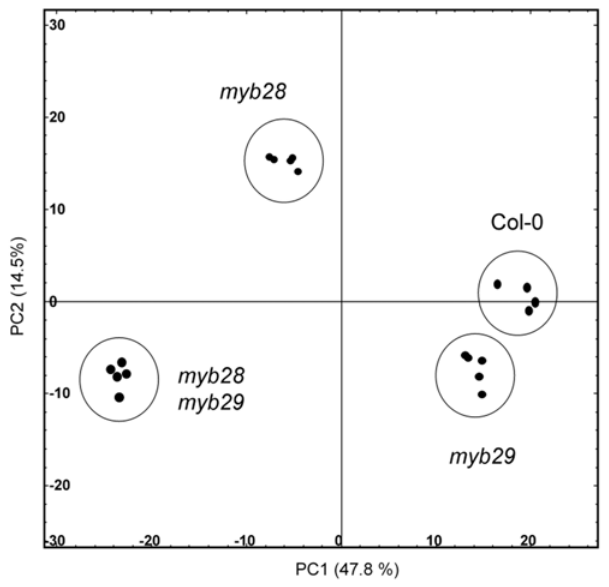
Figure 3. Score plot from principal component analysis of LC- MS metabolic profiles of wild type and mutant Arabidopsis lines. Contributions of principal components to separation of the samples are indicated on the